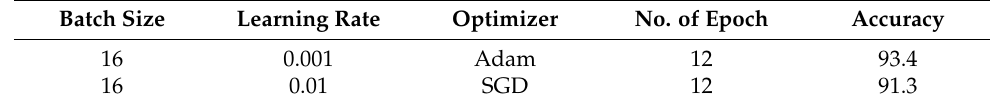
Figure 5. Flow diagram of the ship detection model .